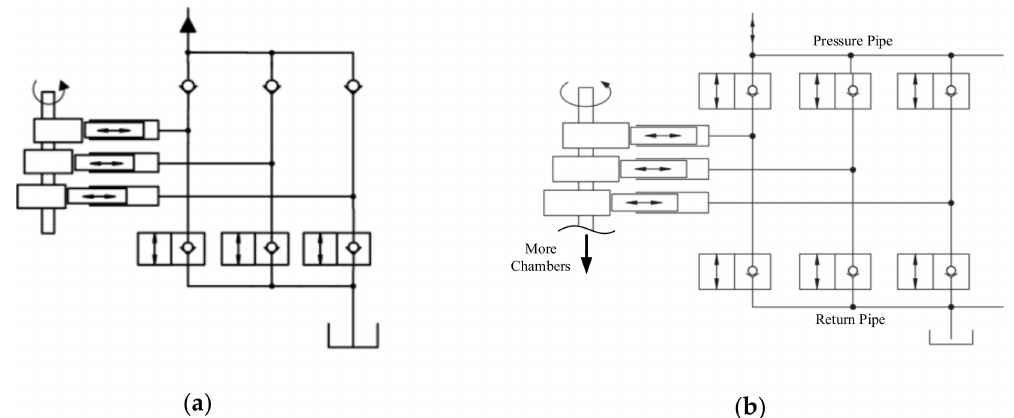
Figure 8. The piston chamber’s independent control digital hydraulic components: ( a ) the digital hydraulic pump; ( b ) the digital hydraulic pump-motor.